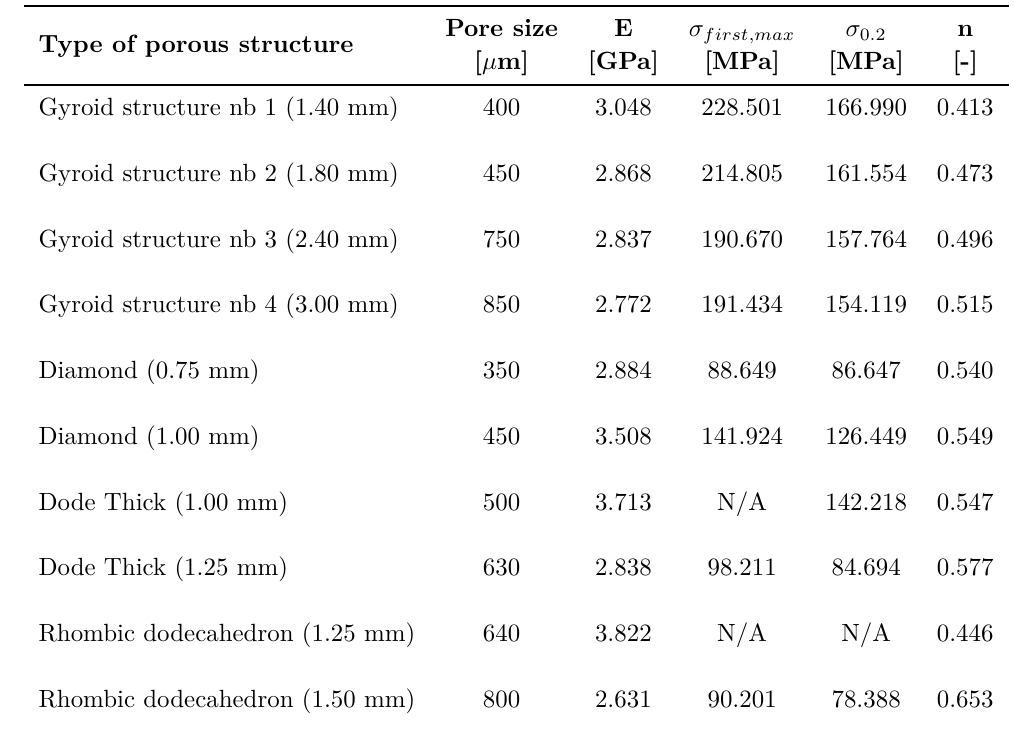
Table 1. The pore size and mean values of the mechanical properties for each type of the trabecular or gyroid structures.